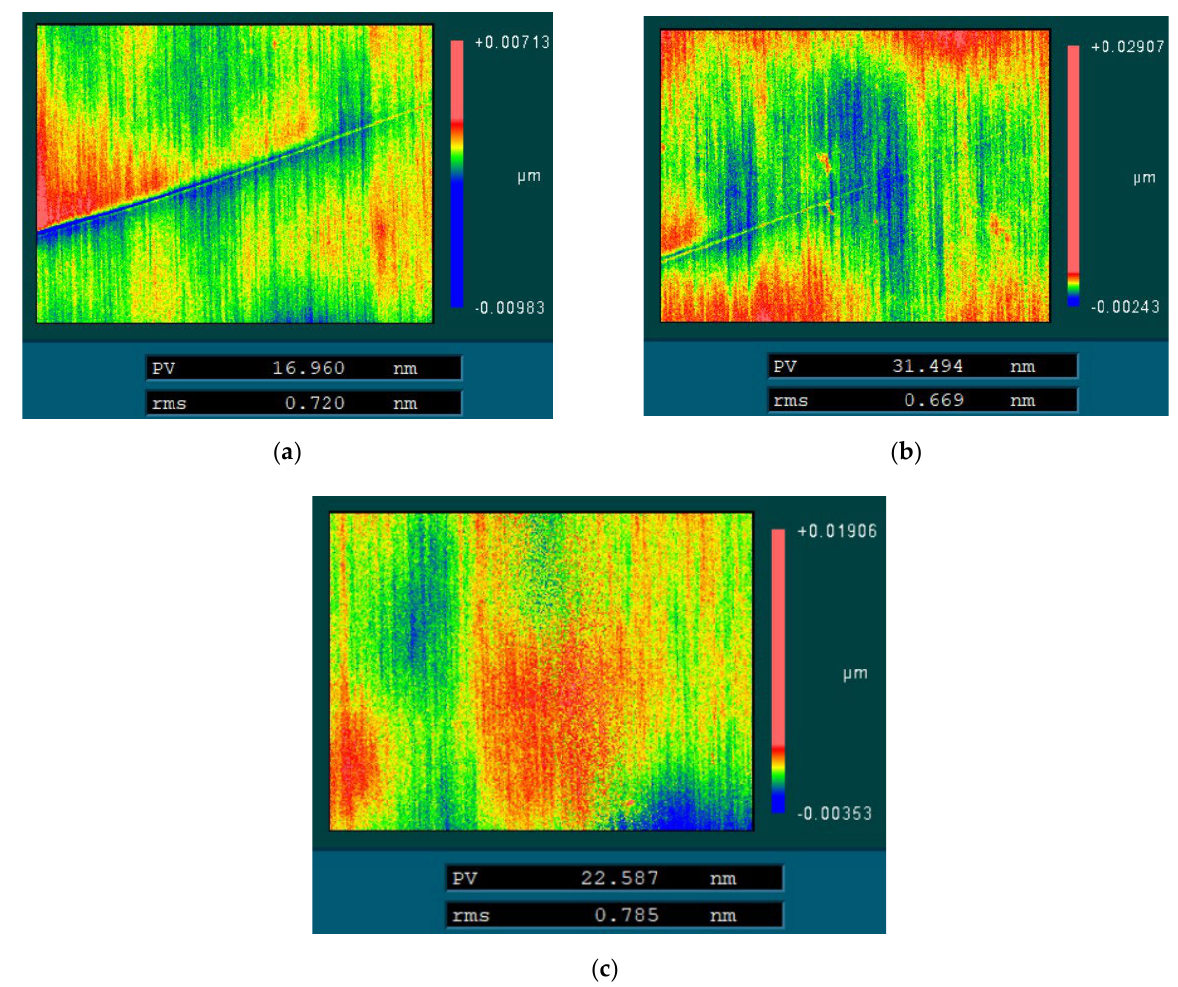
Figure 16. Scratch and surface roughness evolution results under uniform scanning removal based on the magnetorheological rotation angle. ( a ) Scratch Evolution Results under the Uniform Scanning Removal of 20 nm Based on the Magnetorheological Rotation Angle; ( b ) Scratch Evolution Results under the Uniform Scanning Removal of 50 nm Based on the Magnetorheological Rotation Angle; ( c ) Scratch Evolution Results under the Uniform Scanning Removal of 100 nm Based on the Magnetorheological Rotation Angle.